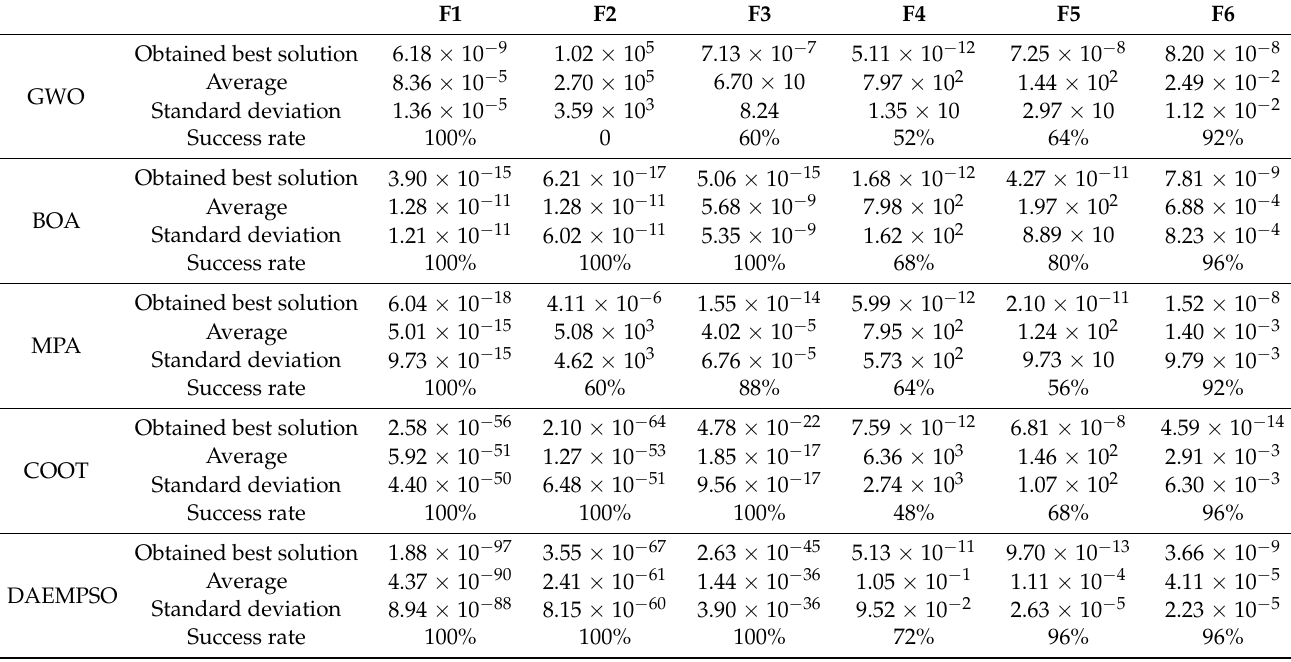
Table 5. Comparison of the optimization results of five algorithms for six test functions (800 dimensions).